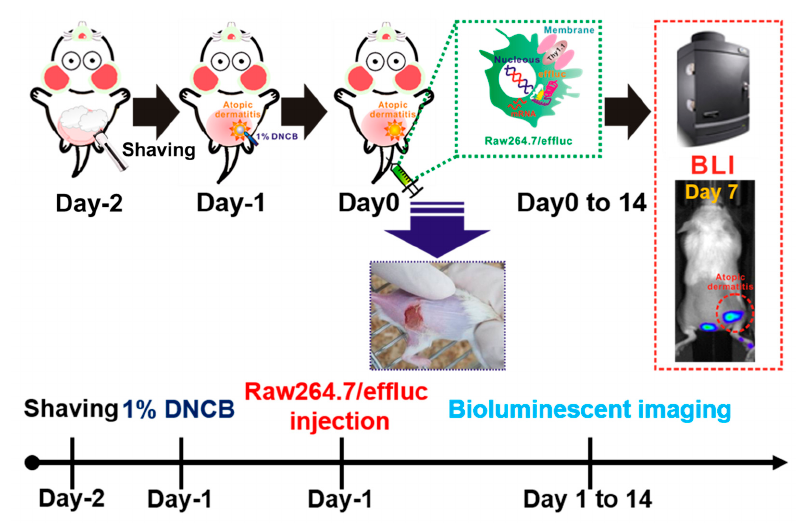
Figure 1. Scheme for the in vivo tracking of the macrophage infiltration in dinitrochlorobenzene (DNCB)-induced atopic dermatitis (AD) using optical reporter-gene-based molecular imaging. Mice were anesthetized with 1%–2% isoflurane gas, and then the dorsal site of the mice was carefully shaved prior to DNCB application. Reporter macrophages were injected via the tail vein, and bioluminescence imaging (BLI) was performed with the optical imaging system.